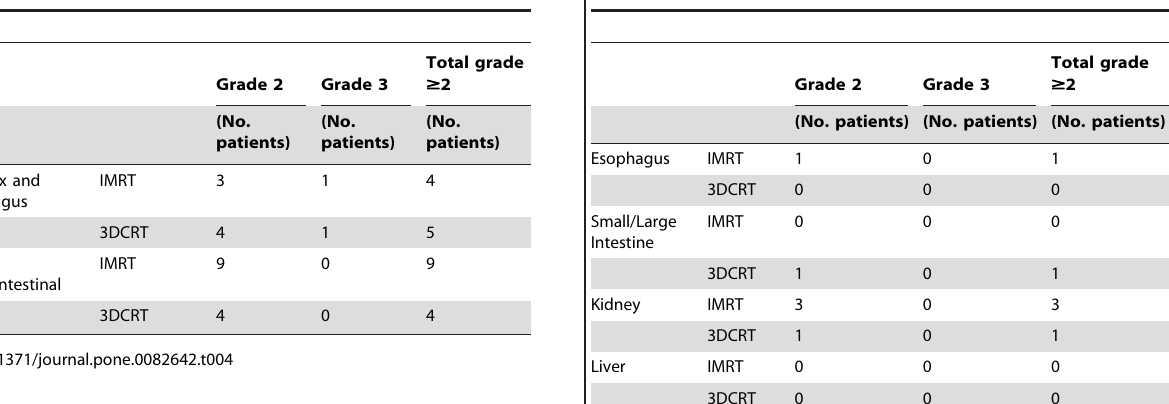
Table 4. RTOG Acute Radiation Morbidity Grade Detail. Table 5. EORTC/RTOG Late Effects Grade